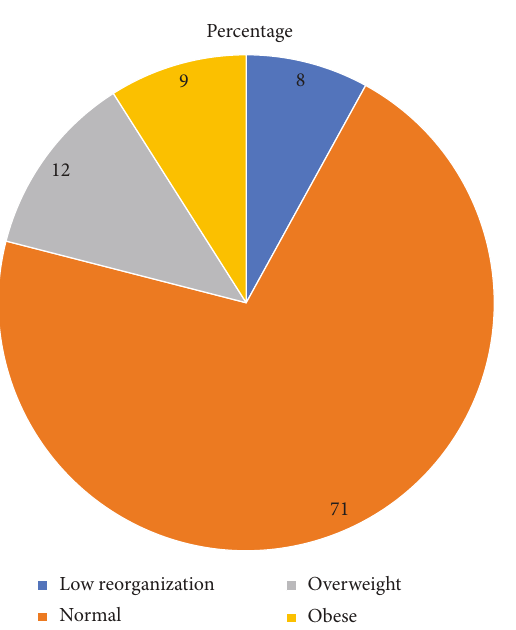
Figure 5: Percentage of male and female students in each